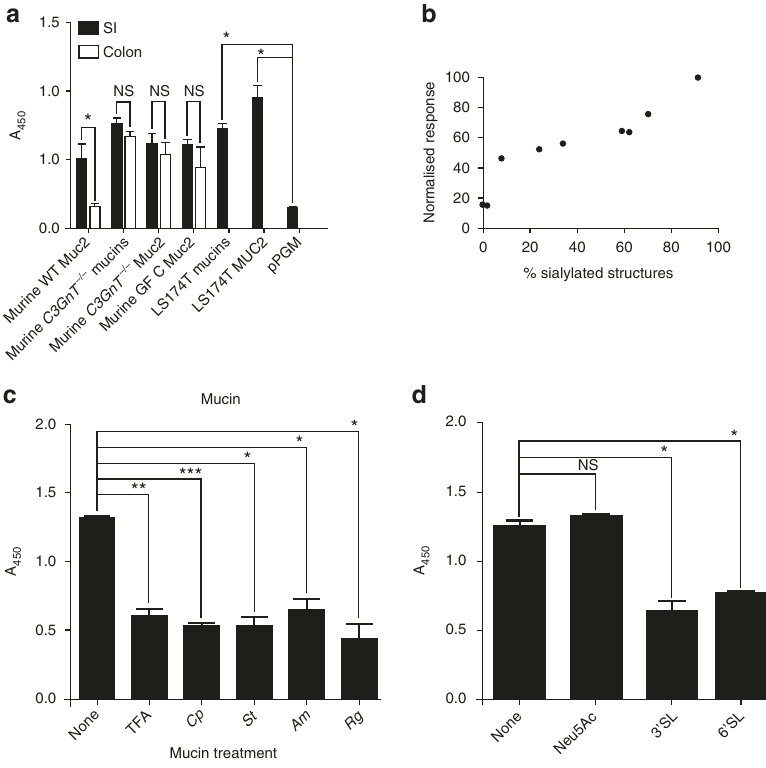
Fig. 7 ELISA of Rg CBM40 binding to puri fi ed mucins. a Rg CBM40 binding to a range of puri fi ed mucins; mucin 2 (MUC2) and mixed mucins (mucins) from human cell line LS174T, puri fi ed pig gastric mucin (pPGM), and murine mucins from germ free (GF), wild type (WT), and C3GnT − / − mice. b Correlation of Rg CBM40 binding with % sialylated structure for each mucin tested. The % sialylated structures was determined by MS. c Rg CBM40 binding to